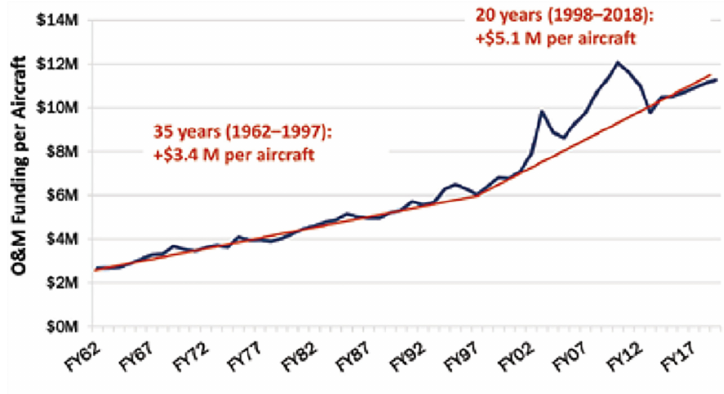
Figure 1. Trends in